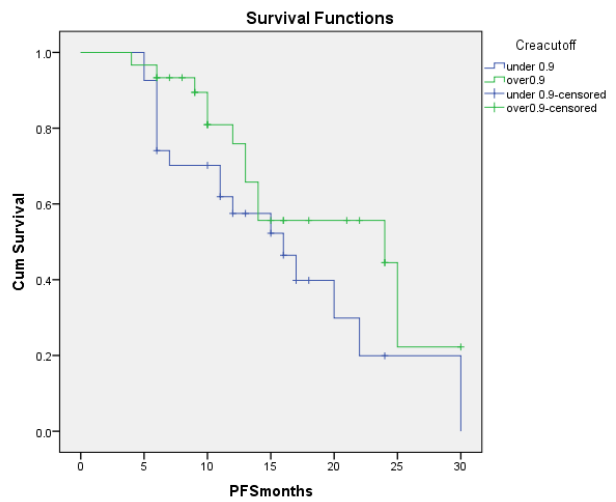
Figure 3. PFS for patients with creatinine under 0.9 vs. creatinine over 0.9 (baseline values).